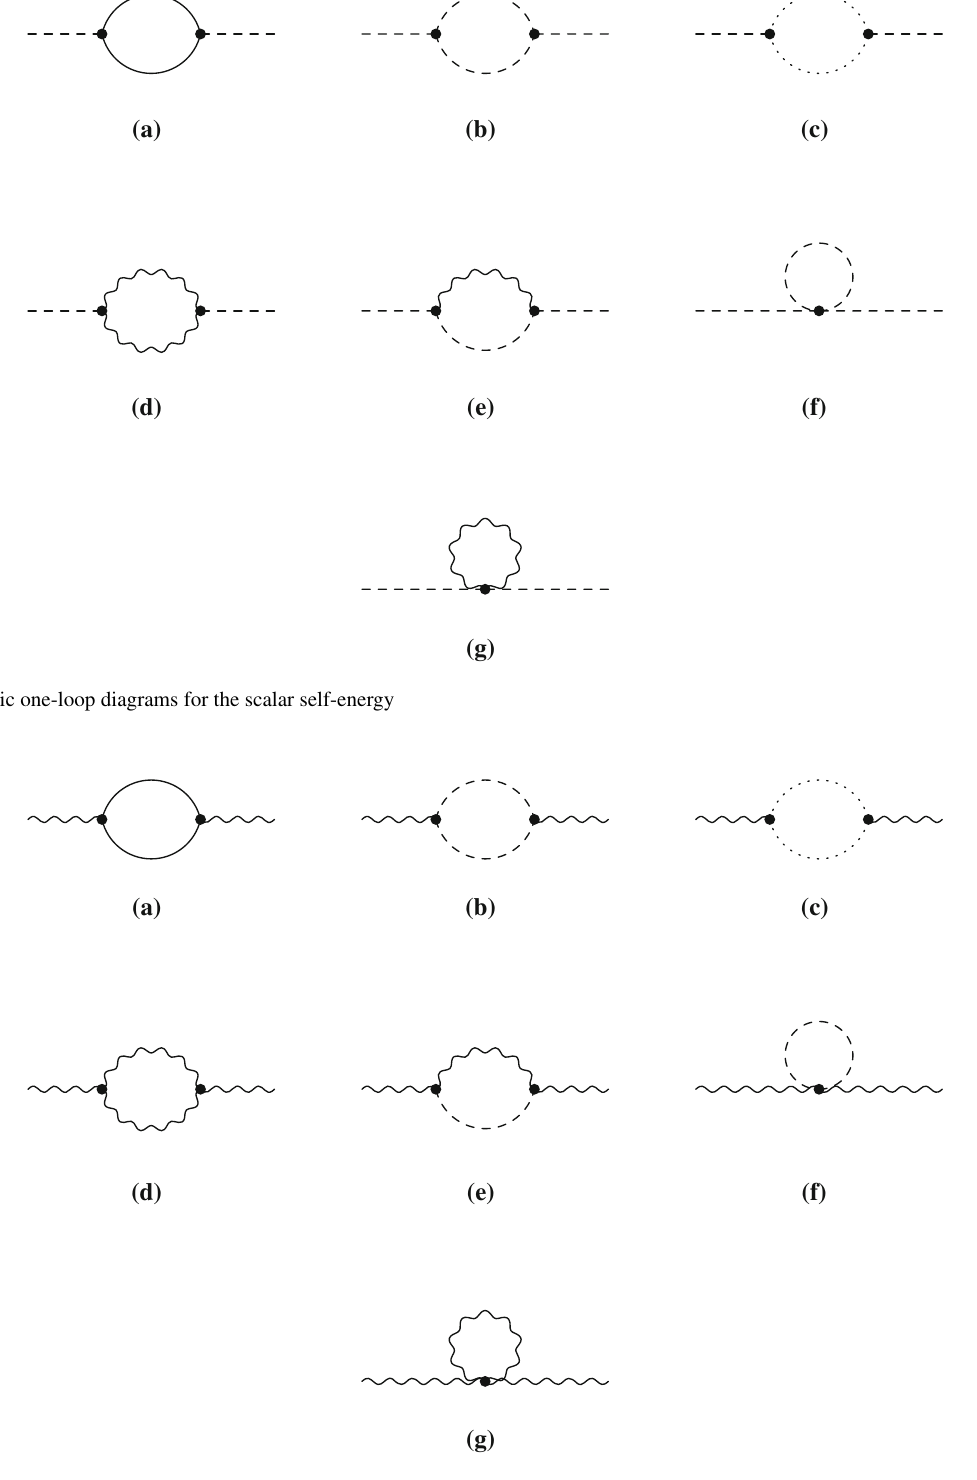
Fig. 14 Generic one-loop diagrams for the gauge boson